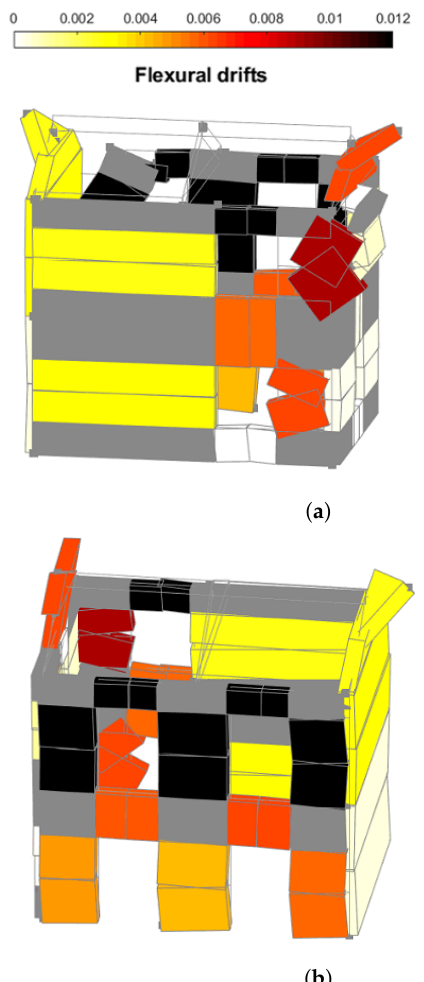
Figure 11. Out-of-plane behaviour (magnification factor × 10): ( a ) North facade-out-of-plane dis- placement involving the 2nd storey piers and the gable. ( b ) South facade-out-of-plane displacement involving only the